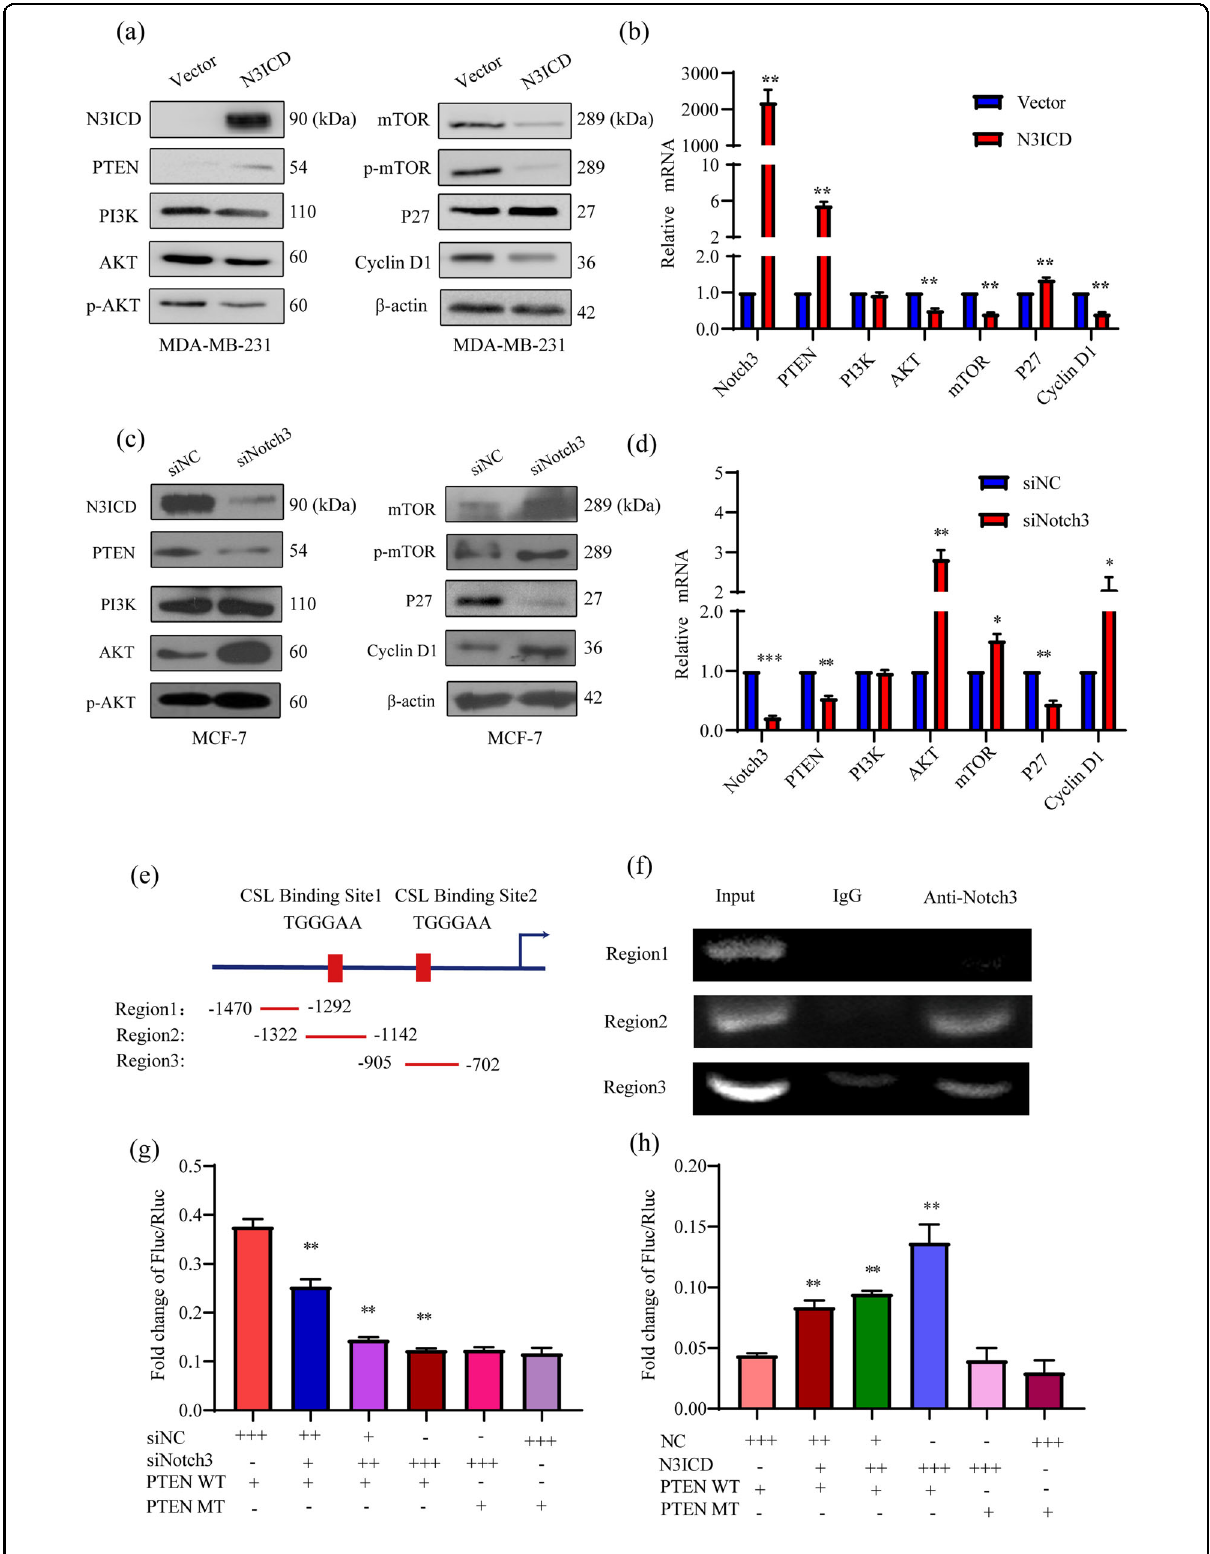
Fig. 2 (See legend on next